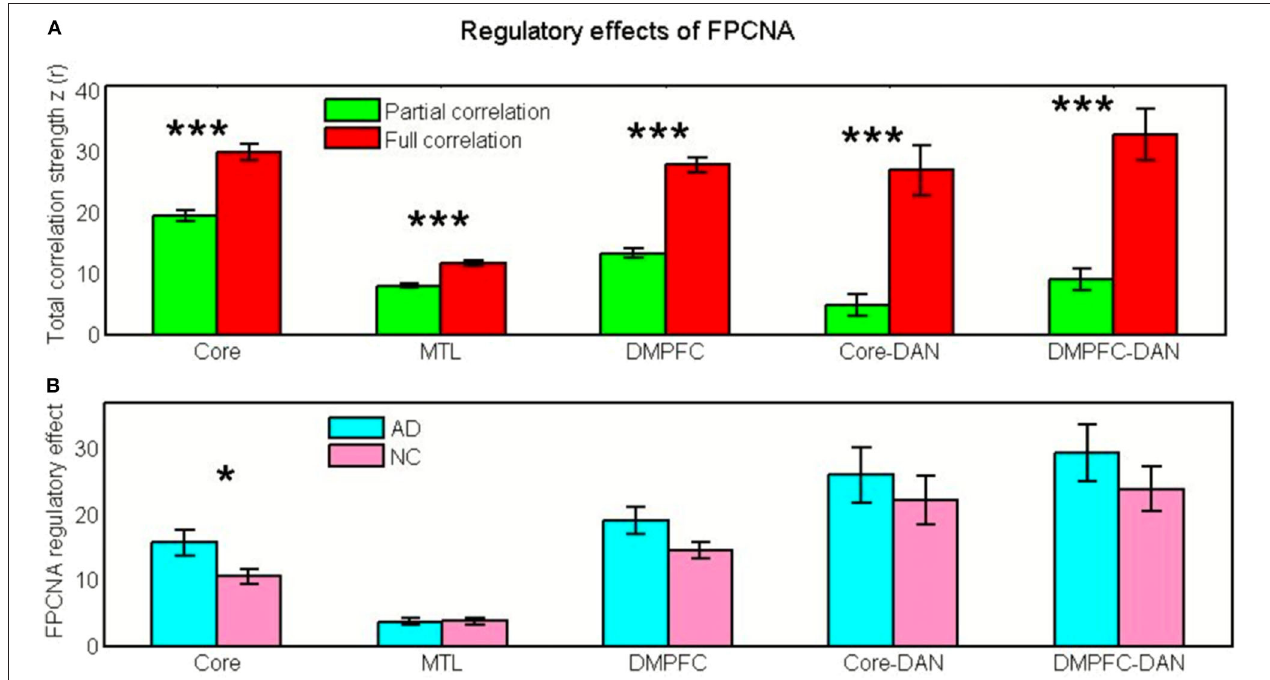
FIGURE 8 | The regulatory effects of the FPCNA. (A) In the NC group, full and partial correlation strength within the Core, MTL subsystem, DM subsystem, between the Core and DAN, and between the DM subsystem and DAN. (B) The regulatory effect of the FPCNA on the Core, MTL subsystem, DM subsystem, interactions between the Core and DAN, and between the DM subsystem and DAN in the NC and AD groups (* p < 0.05, ** p < 0.005, *** p < 0.001).